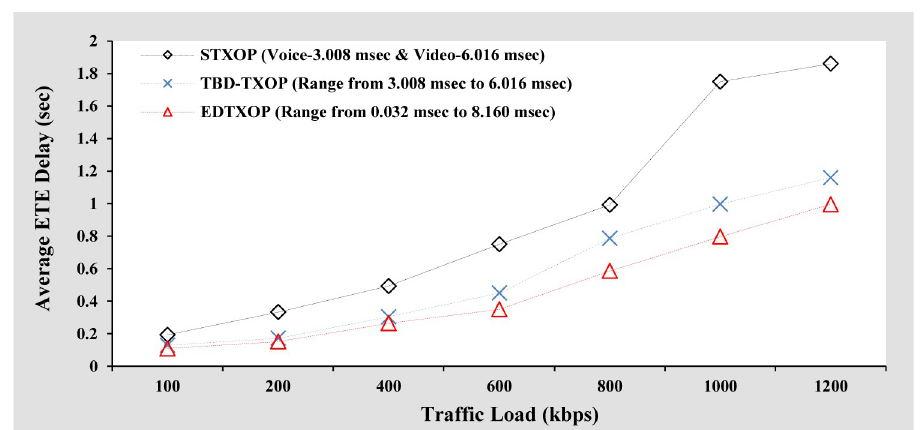
Fig 10. Average ETE delay analysis based on increasing packets arrival rate.